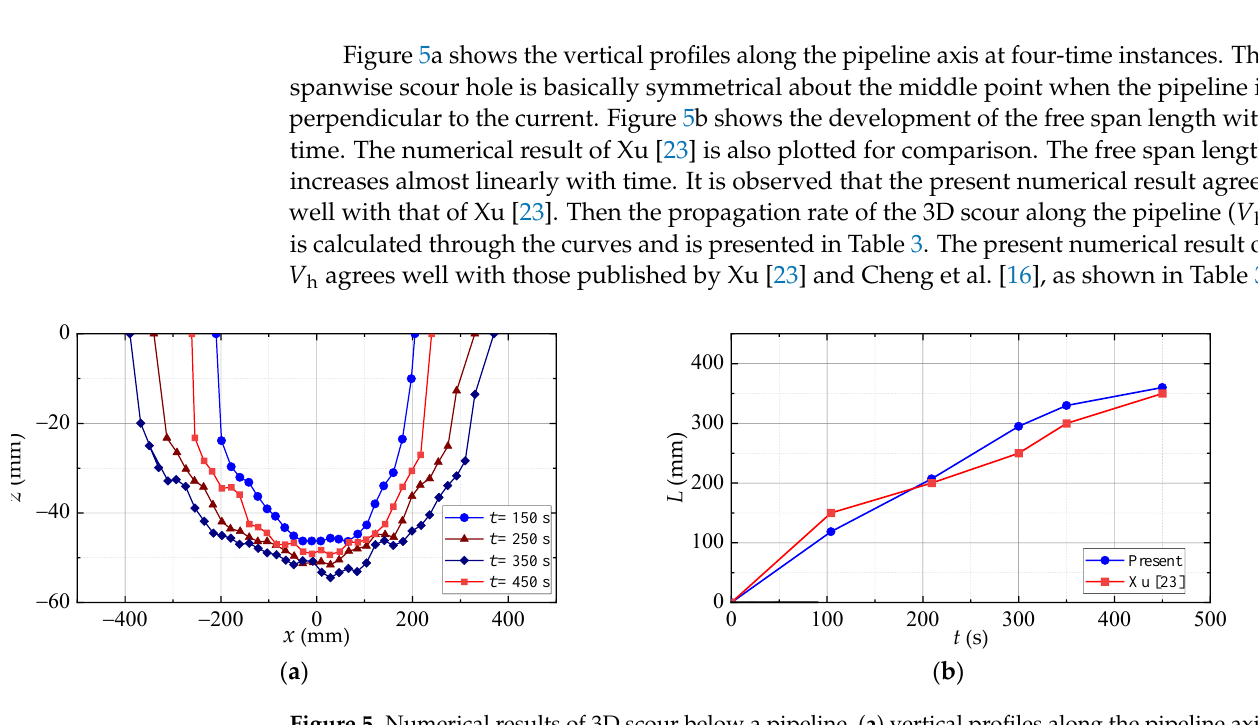
Table 3. 3D-single pipeline scour model parameters.